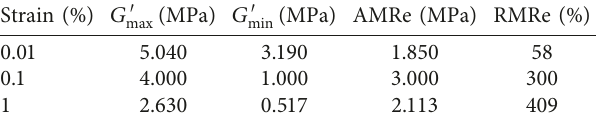
Table 2: Parameters of MRE with external magnetic field at dif- ferent shear strains.